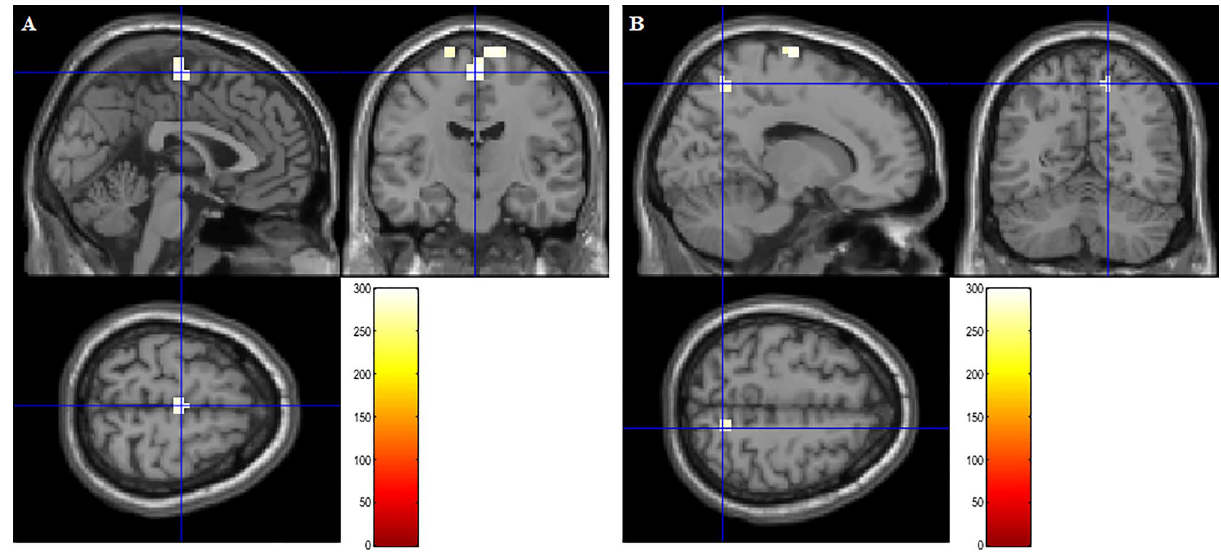
Figure 2. Significant positive effects of loneliness on resting-state functional connectivity with IFG as the seed region. The color represents the strength of the TFCE value. ( A ) The result was corrected within SMA. ( B ) The result was obtained using the TFCE of p < .05 based on 5,000 permutations. The result was corrected within the right